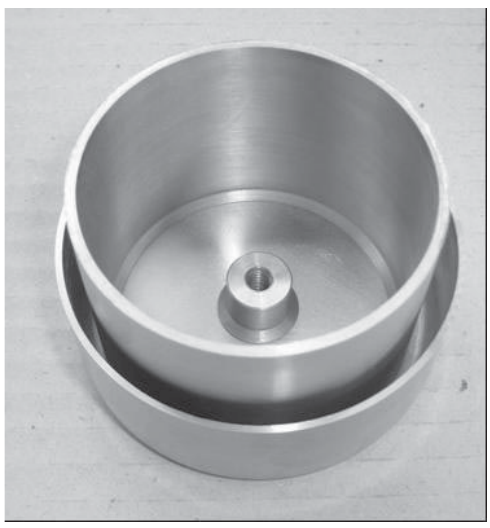
FIG. 2. Sketches of the 352 MHz, (cid:1) 0 : 31 half-wave resonators, cut in two perpendicular planes.